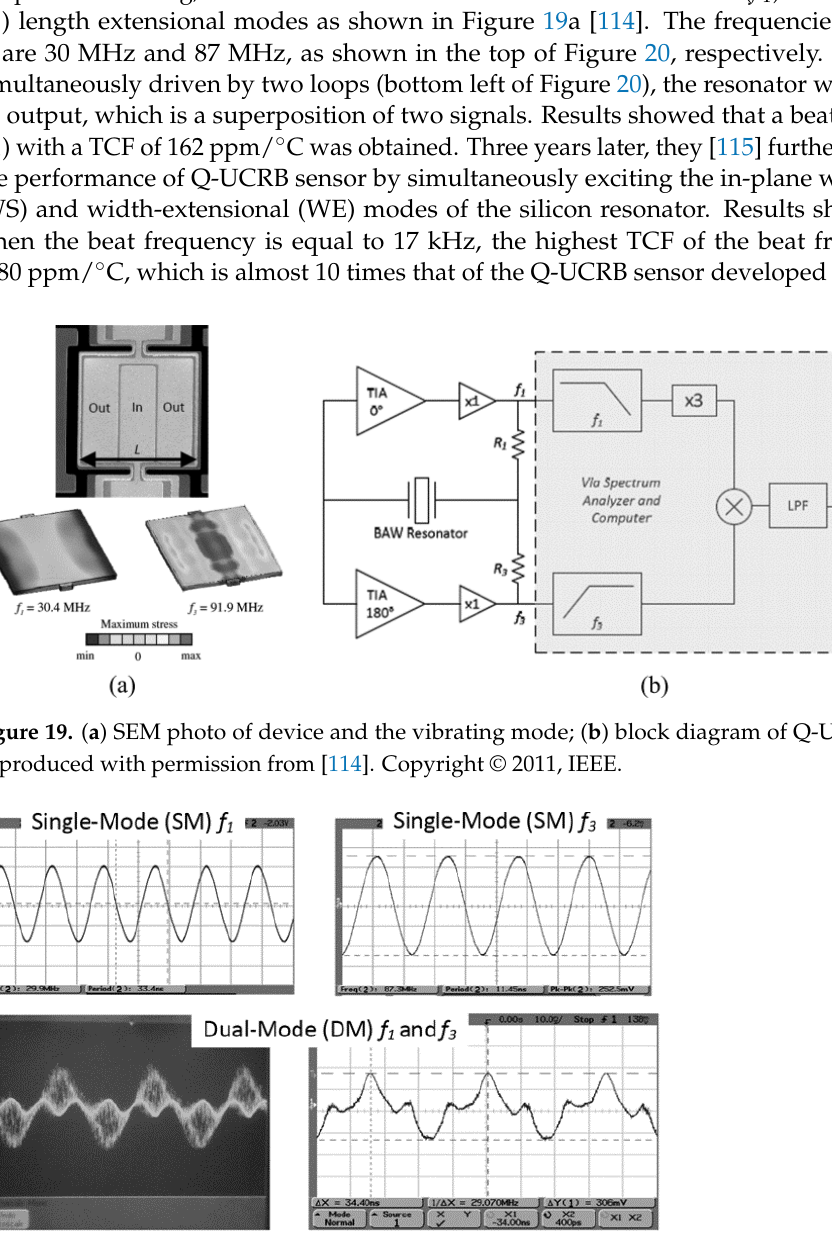
Figure 20. ( top ) Oscillator response for f 1 and f 3 single-mode excitation; ( bottom left ) dual-mode excitation at f 1 and f 3 ; ( bottom right ) dual-mode output signal after averaging. Reproduced with permission from [114]. Copyright © 2011, IEEE.